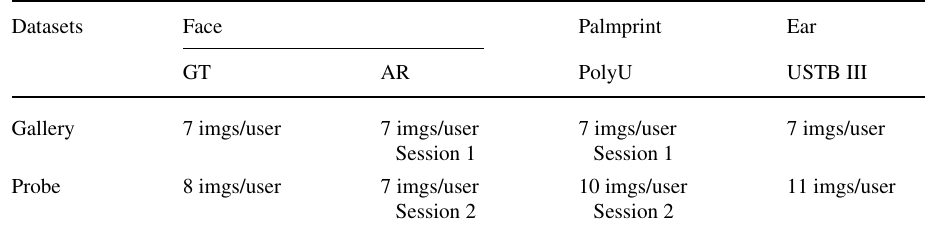
Fig. 1 Example images of one user in each unimodal